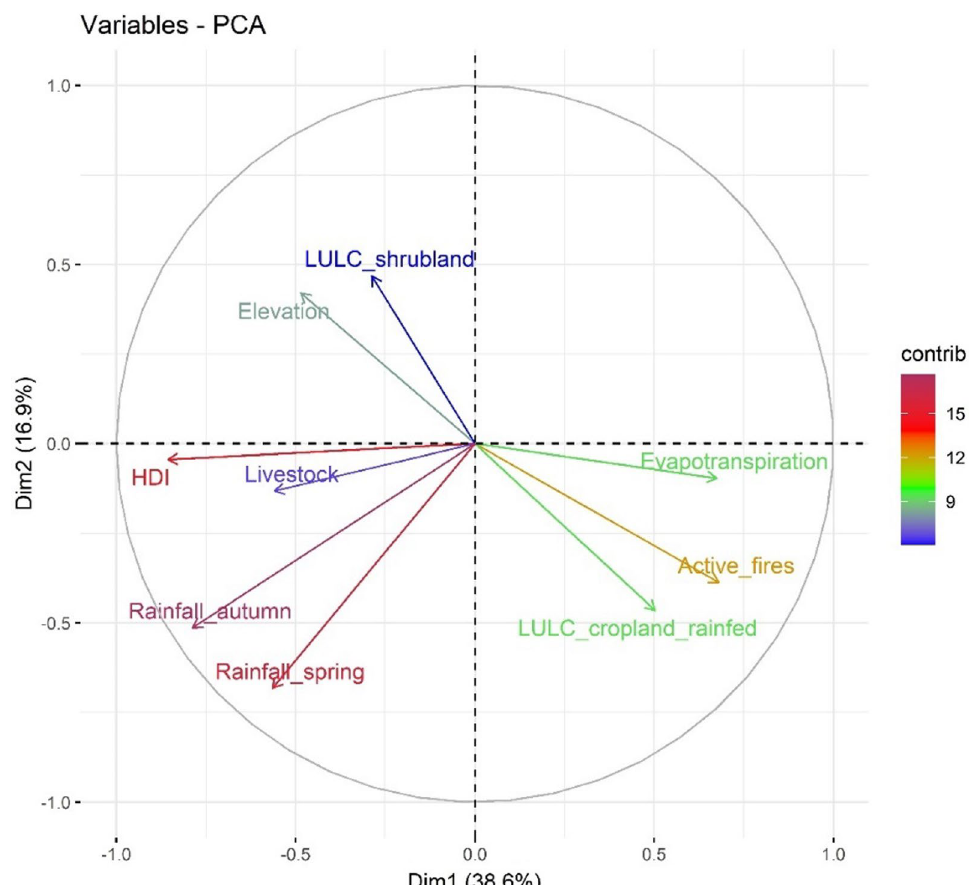
Fig. 3 Biplot resulting from two PC‑based PCA. The colors of the arrows represent the contribution (in %) of each variable evaluated for PC1 and PC2 over the Brazilian Cerrado. The x and y axes correspond to the degree of relationship of each PCA resulting correlation analysis. In this instance, x and y refer to PC1 and PC2, respectively. These respective axes’ values range from – 1 to